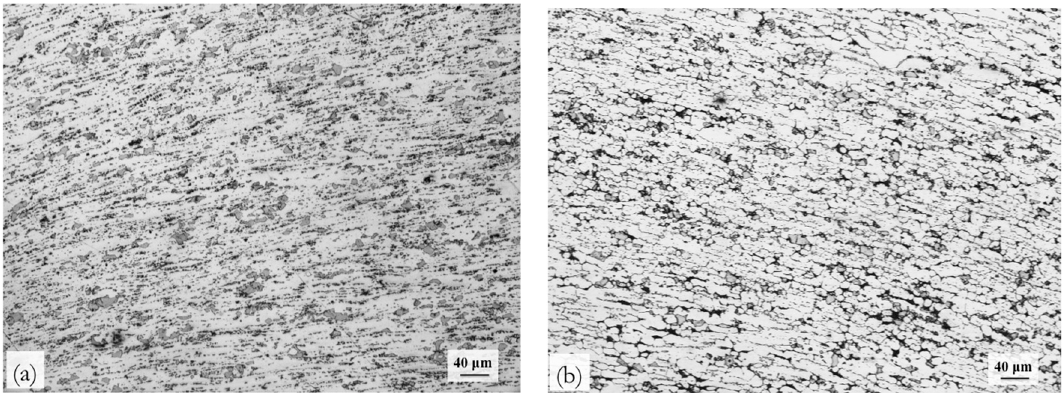
Figure 13. Optical microstructures of the ABaX633 alloy forged at ( a ) 420 °C/0.01 mm · s − 1 (correspond to Domain 1 in the processing map) and ( b ) 500 °C/0.1 mm · s − 1 (Domain 2). Forging axis is vertical.